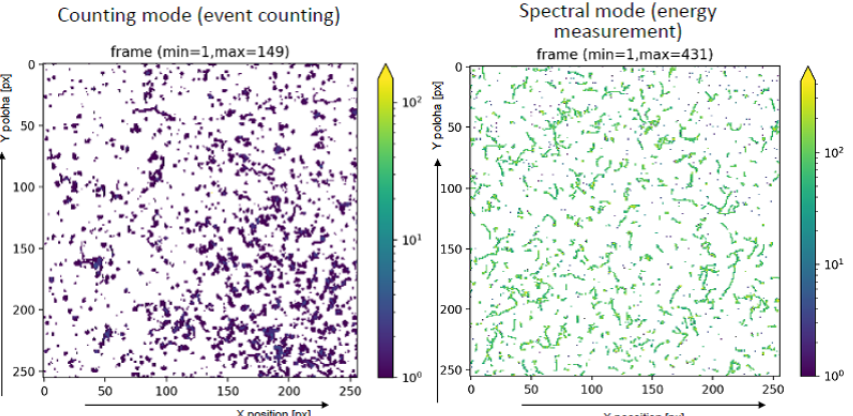
Figure 11. Detection and radiation field visualization of a mixed-field consisting of X rays, gamma rays and alpha particles from a 241-Am source by the developed payload. The images show the integrated (long time exposure over many Timepix frames) detection and track visualization of the irradiated field registered by the pixel detector with a 2000 µ m CdTe sensor. Data are shown in counting mode ( left ) and spectral mode ( right )—see text. The per-pixel counting and energy response, respectively, are displayed in